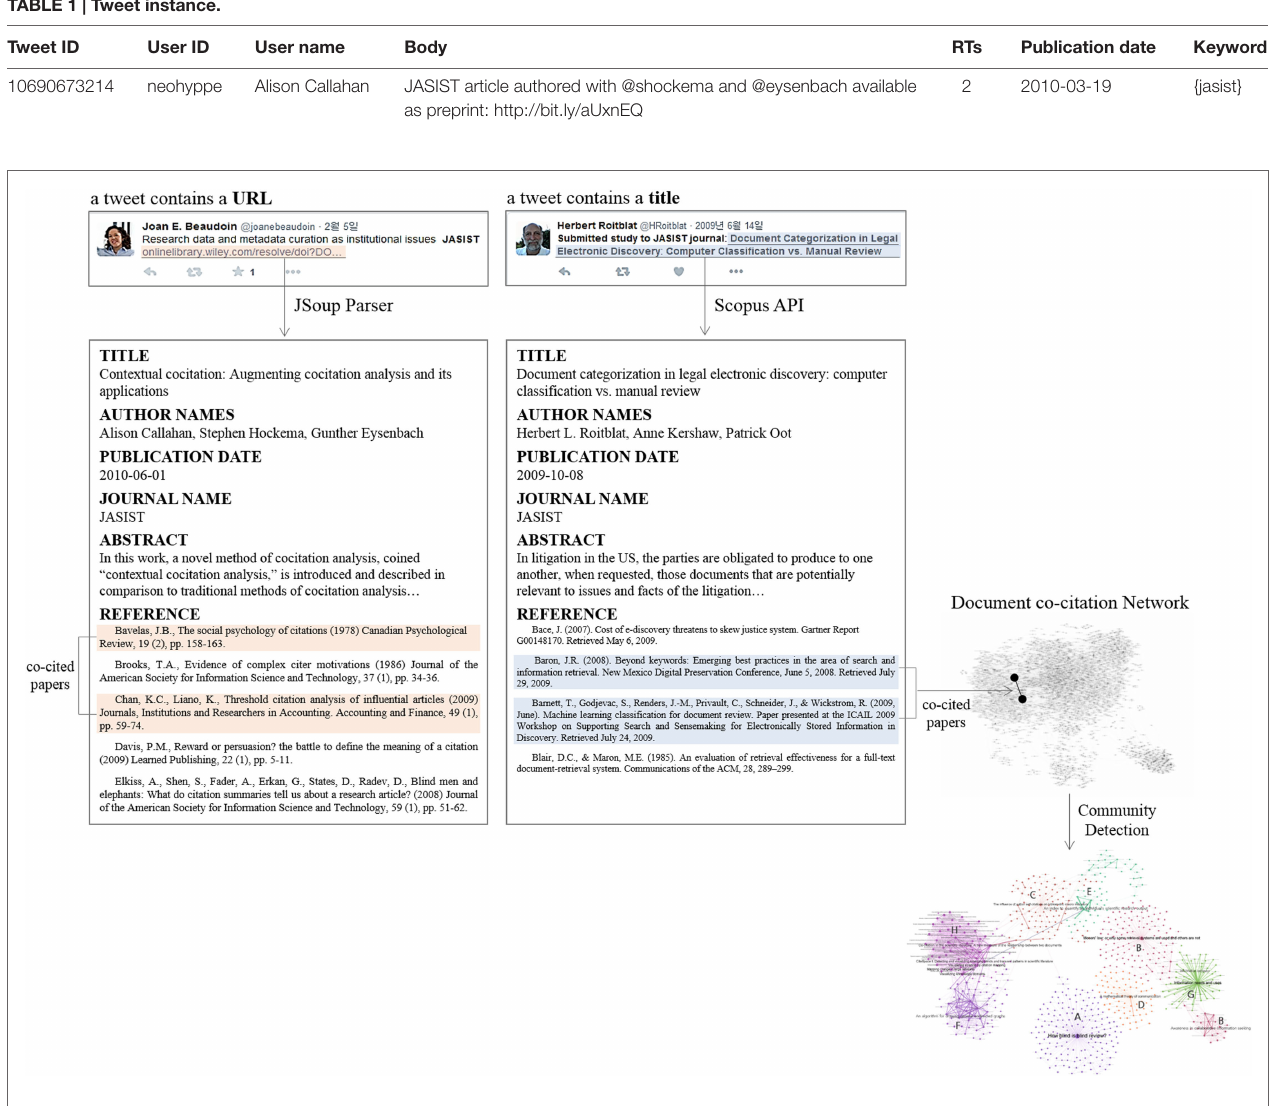
FigUre 3 | a Twitter document co-citation network construction